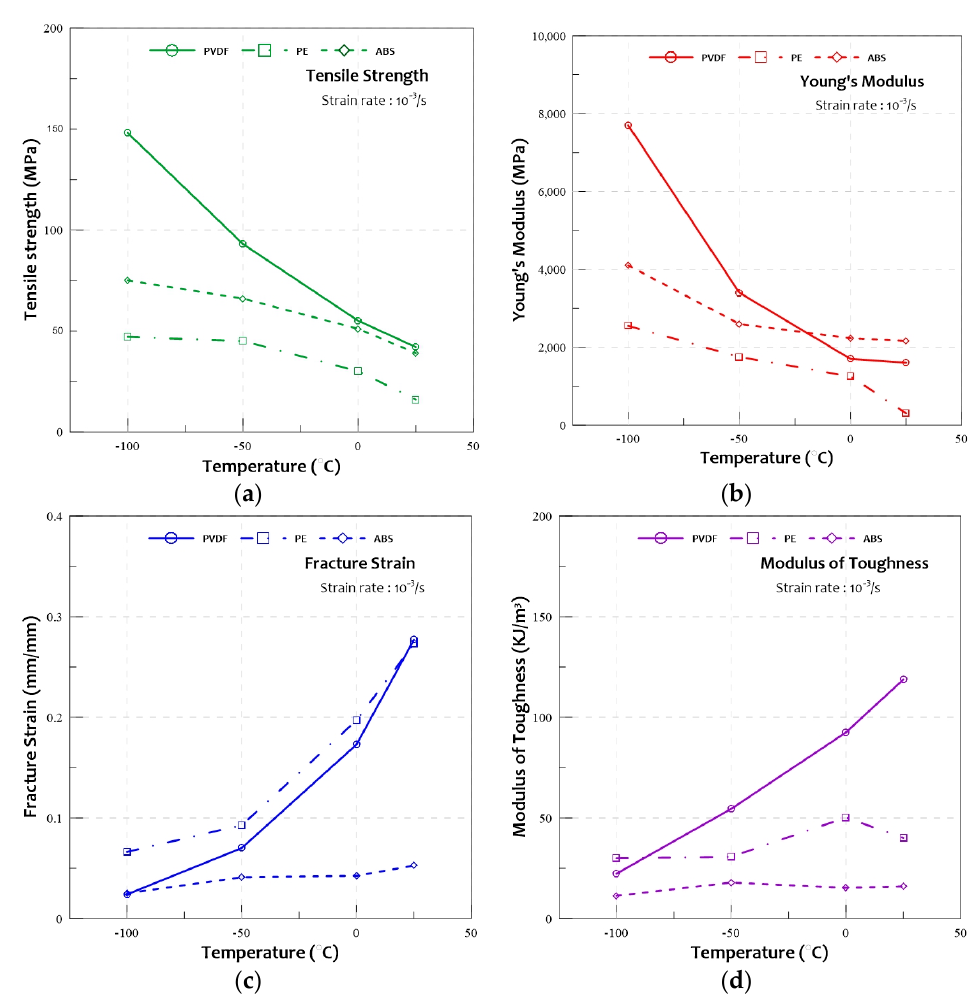
Figure 9. Temperature-dependent mechanical properties of the polymers: ( a ) tensile strength, ( b ) elastic modulus, ( c ) fracture strain, and ( d ) modulus of toughness.